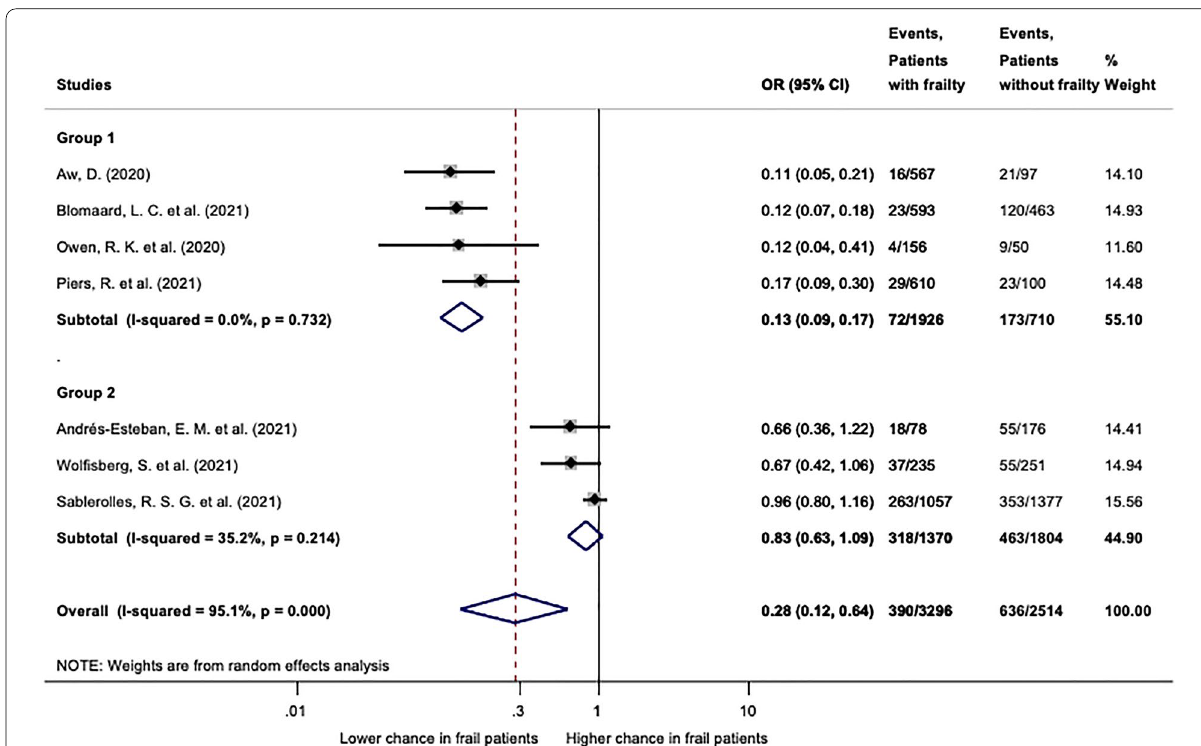
Fig. 5 ICU admission in patients with frailty indicated by CFS 1–3 vs 4–9. Patients living with frailty (CFS 4–9) have significantly lower odds to be admitted to the ICU (overall OR: 0.28; CI 0.12–0.64). In group 1 chance for ICU admission was significantly lower in patients with frailty (OR: 0.13; CI 0.09–0.17), however in group 2 to there was no significant difference (OR: 0.83; CI 0.63–1.09). For further explanation please see text. Please note, that in contrast to the significant overall heterogeneity, both subgroups were statistically homogeneous. OR: odds ratio; CI: confidence